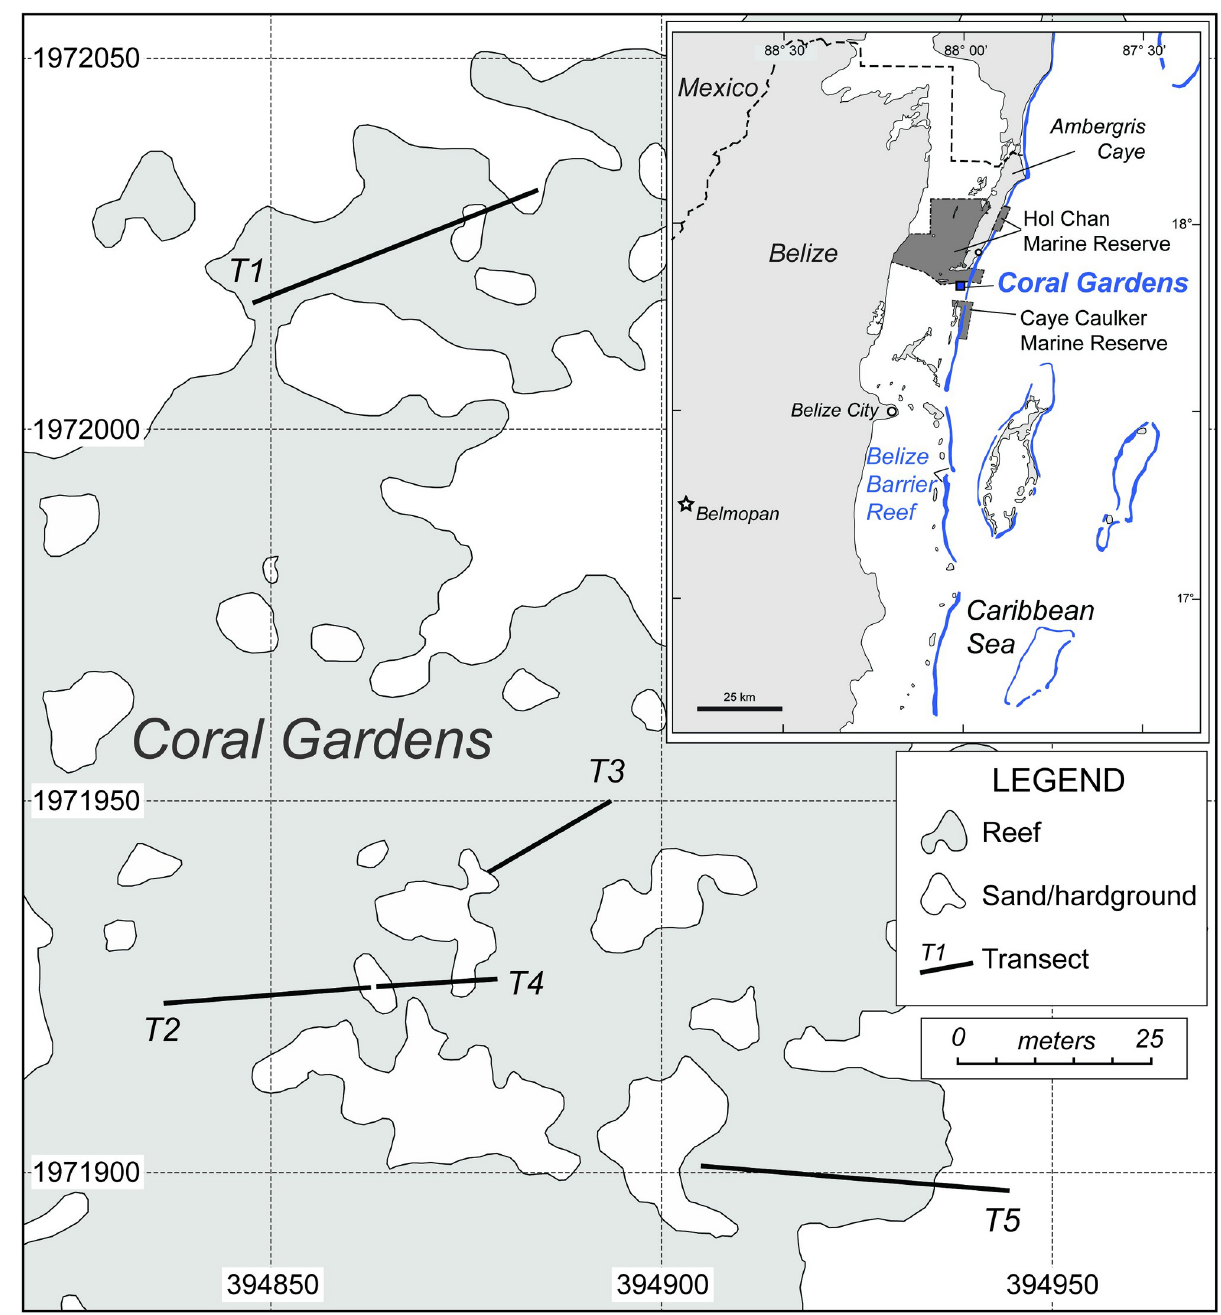
Fig 1. Index map for Coral Gardens including locations of transects used in this study. Coordinates are UTM northings and eastings in Zone 16. Modified from